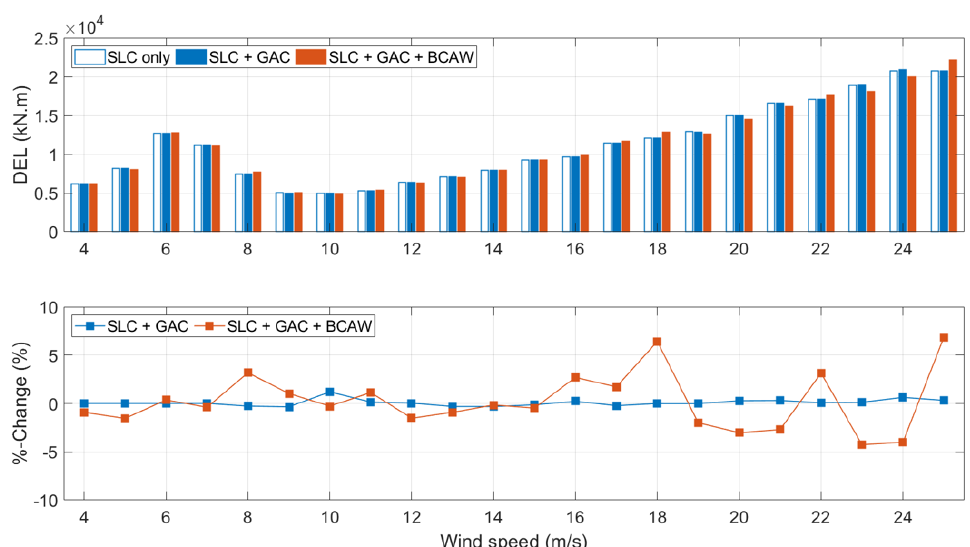
Figure A7. Variation of the DELs of the tower base side-side bending moments from cut-in to cut-out wind speed under DLC 1.2 with different control architectures. Top—Dimensional DELs; Bottom—Percentage changes with respect to the ‘SLC Only’